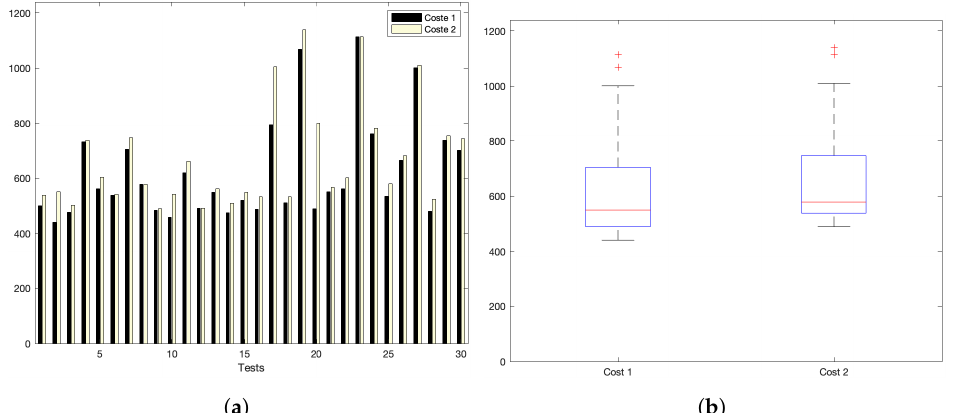
Figure 7. Medium request-rate scenario: ( a ) individual test values for cost 1 and cost 2 ; ( b ) summary